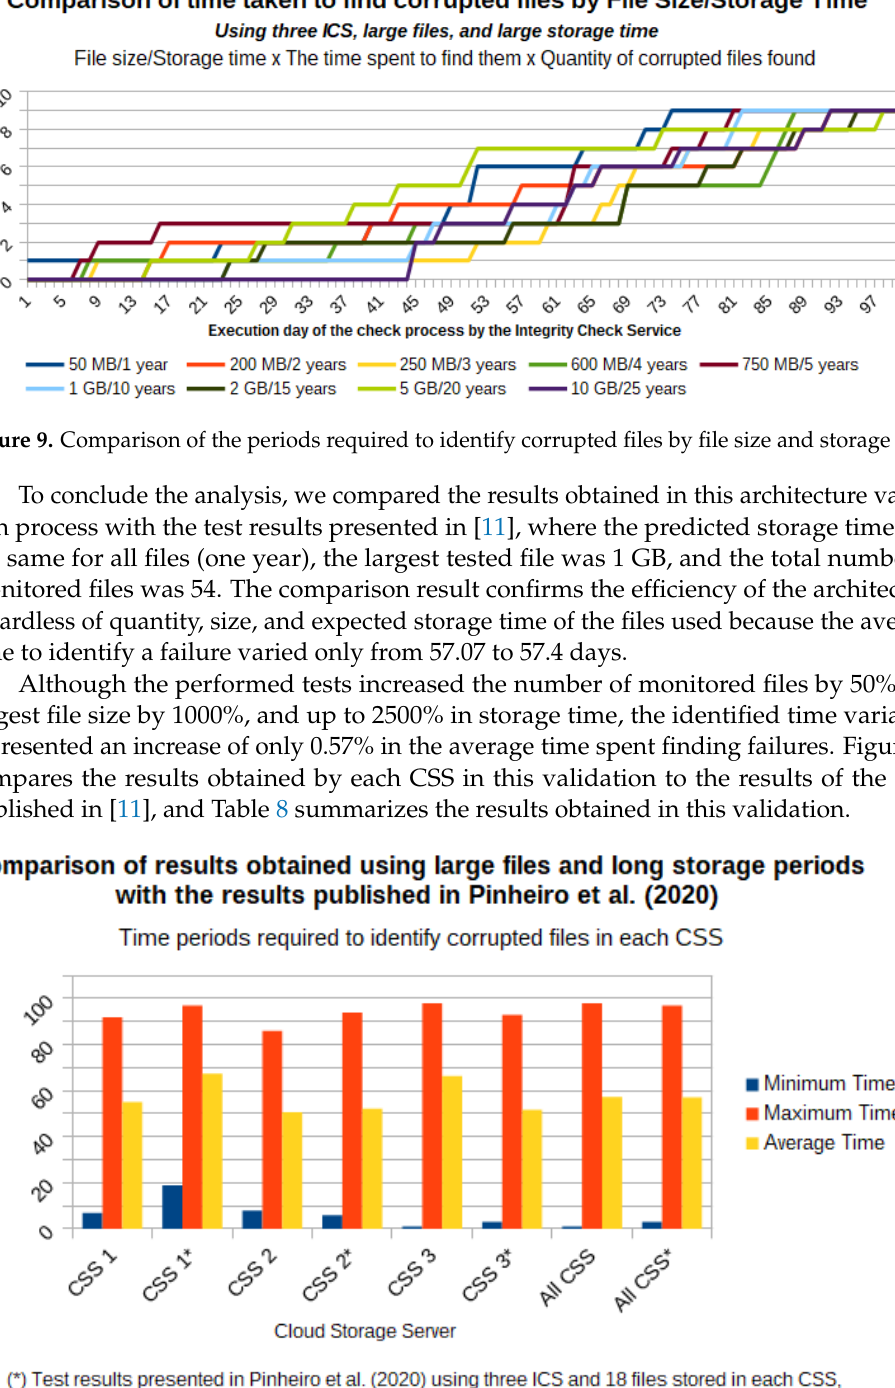
Figure 10. Comparison of results obtained using large files and long storage periods with the results published in Pinheiro et al.